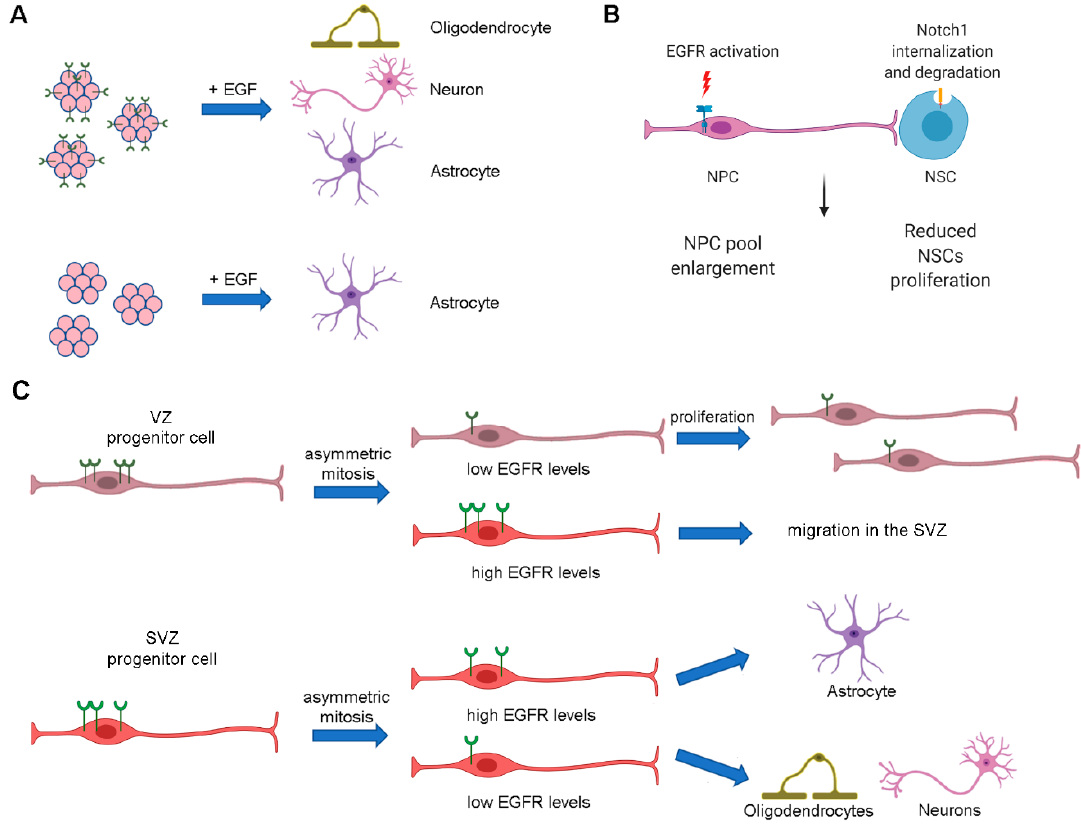
Figure 4. EGFR regulates neural stem cells and progenitors. ( A ) Neural stem cells can grow in vitro as neurospheres. These clonal aggregates can di ff erentiate into oligodendrocytes, neurons or astrocytes if they express EGFR while, following EGFR ablation, they can di ff erentiate only into astrocytes. ( B ) Following cell-cell interaction, EGFR activation in neural progenitor cells (NPCs) stimulates Notch1 ubiquitination and degradation in adult neural stem cells (NSCs). This mechanism is responsible for NPC pool enlargement at the expense of NSC proliferation. ( C ) In the VZ, NPCs expressing high EGFR levels can undergo asymmetric mitosis producing a daughter cell expressing low EGFR levels which continues to proliferate and a daughter cell expressing high EGFR levels which migrates in the SVZ. Here, it can divide asymmetrically producing a daughter cell with high EGFR levels that di ff erentiates into astrocyte and a daughter cell with low EGFR levels that enters in a diverse di ff erentiation